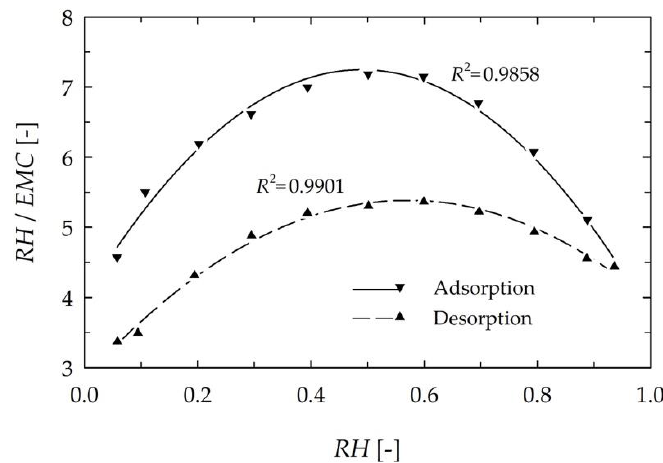
Figure 5. Experimental sorption data (dots) and results of modelling (lines) with Guggenheim, Anderson, and de Boer (GAB) model of the juvenile and mature lime ( Tilia cordata Mill.) wood at 20 °C take into account growth conditions ( a )—forest (A), ( b )—roadside (B), ( c )—urban agglomeration (C).